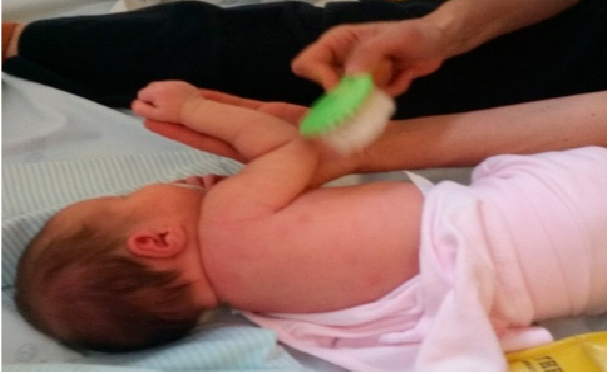
Figure 5. Sensory stimulation with a soft brush.